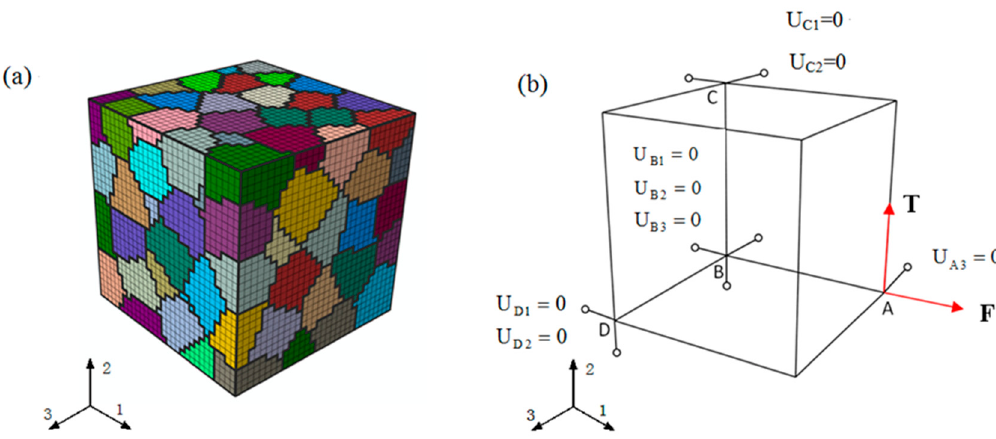
Figure 5. The FEM (Finite Element Model) of thin-walled tube specimen: ( a ) a grain contain multiple elements; ( b ) each element standards for a grain.